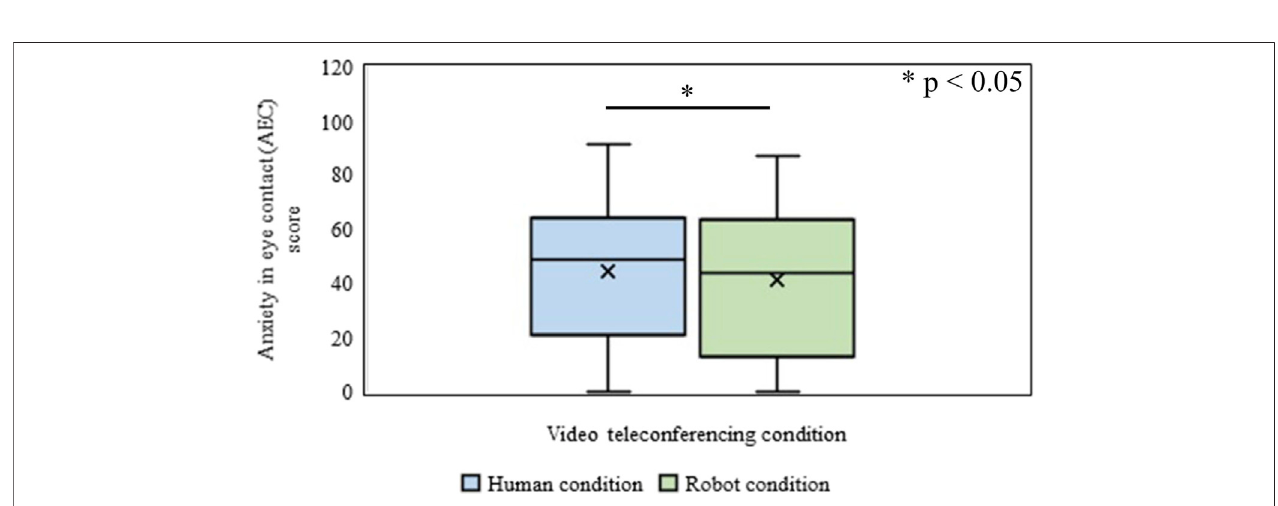
FIGURE 5 | Anxiety in eye contact (AEC) in Human and Robot conditions of Experiment- Ⅰ .